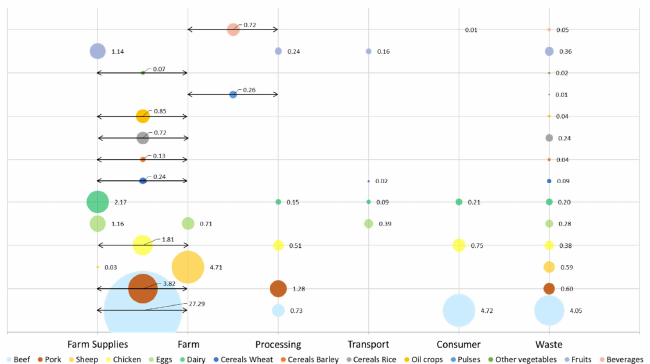
Figure 1. Greenhouse gas emissions (GHGEs) of different food product categories (see bottom coloured legend). The numbers represent the average impact values from some studies on kg CO 2 eq released per 1 kg of the product; the vertical lines represent the stage of the food chain to which the impact relates. When the impact relates to two stages, it is placed in the middle with a horizontal arrow connecting the stages. The absence of a circle in a given stage shows that no data were available in the literature. The consumer stage includes impacts from retail, restaurants, and other parts of the food service sector; waste represents the environmental impact of the food chain accumulated in waste at the end of the chain. Adapted from [48–80].